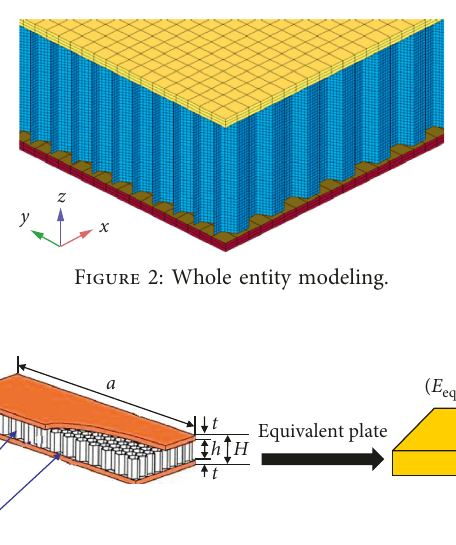
Figure 3: Equivalent